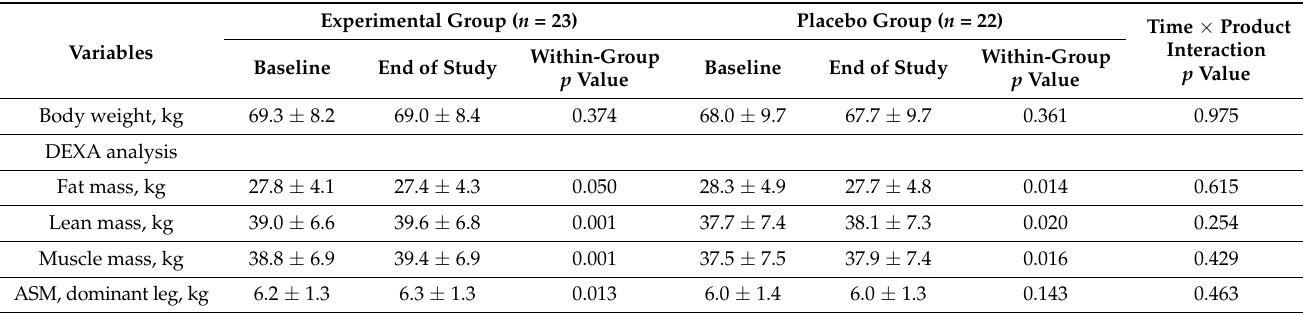
Table 2. Changes in body weight and body composition measured by DEXA at the end of the study after 12 weeks of food supplementation with a spinach extract or placebo.